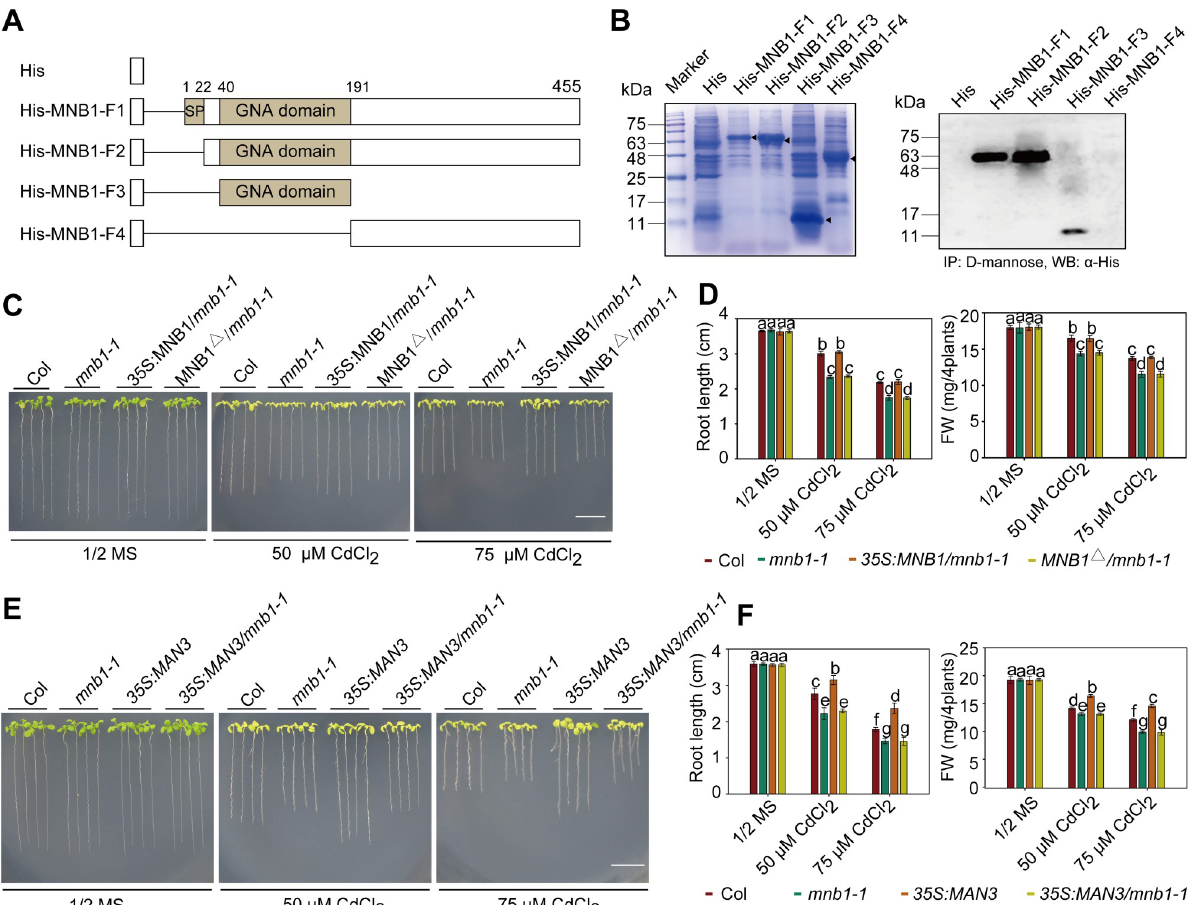
Fig 3. Mannose binding to MNB1 is required for MAN3-mediated Cd tolerance. (A) Schematic representation of MNB1 and MNB1 key deletion constructs. (B) Direct proof of mannose binding to the specific region of MNB1. Immunoblot analysis of MNB1 using the anti-His antibody. His- tagged MNB1 and MNB1 deletion constructs were expressed in E . coli (left panel) and purified using d-Mannose-agarose columns. Arrowheads indicate expressed His-tagged recombinant proteins. α -His, anti-His antibody; IP, immunoprecipitation; WB, western blotting. (C) Cd tolerance of the Col, mnb1-1 , 35SMNB1 : mnb1 and MNB1 Δ / mnb1 seedlings. (D) Root length and fresh weight of plants described in (C). (E) Cd tolerance of the Col, mnb1 , MAN3-OE , MAN3-OE/mnbl1 seedlings. (F) Root length and fresh weight of plants described in (E). In (C) and (E), three-day-old seedlings grown on 1/2 MS medium were transferred to 1/2 MS medium with or without 50 or 75 μ M CdCl 2 for about 2 weeks. Scale bar = 1 cm. In (D) and (F), three independent experiments were done with similar results, each with three biological replicates. Four plants per genotype from one plate were measured for each replicate. Data are presented as means ± SD, n = 3. Bars with different lowercase letters are significantly different at P < 0.05 (Tukey’s test).